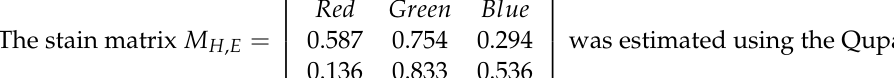
Figure 4. Stain deconvolution. ( a ) Normalized image. ( b ) Hematoxylin channel. ( c ) Eosin channel.